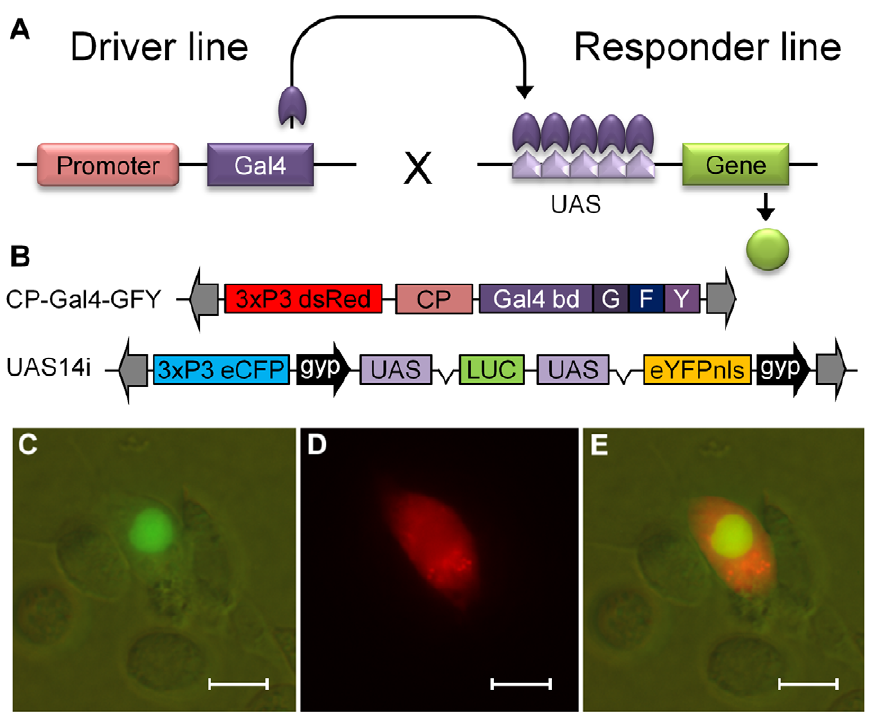
Figure 1. Gal4 driver and UAS responder constructs and eYFP nuclear localization. Illustrations of (A) the bi-partite Gal4-UAS system and (B) the Gal4 driver and UAS responder constructs used for transformation of An. gambiae mosquitoes. The driver cassette (upper) consists of the An. gambiae CP promoter upstream of the 147aa DNA binding domain from Gal4 fused in frame to three VP16 minimal activation domains, contained within a piggyBac vector carrying the dsRed marker gene under control of the 3 6 P3 promoter. Grey arrows show piggyBac repeats. The responder cassette (lower) consists of UAS regions upstream of both LUC and eYFPnls, and flanked by gypsy insulator sequences. These are contained within a piggyBac vector marked with eCFP under control of the 3 6 P3 promoter. (C to E) An. gambiae cell line co-transfection with Gal4 driver (pSL*LRIM1- Gal4 D ), responder (pSL*UAS-eYFPnls-g) and a control plasmid expressing cytoplasmic dsRed under the Drosophila Actin5C promoter. (C) Localisation of eYFP to the cell nucleus observed with fluorescein filter and bright field (D) Cytoplasmic expression of dsRed observed with a rhodamine filter; (E) A composite image of C and D. Scale bars are 5 m M.